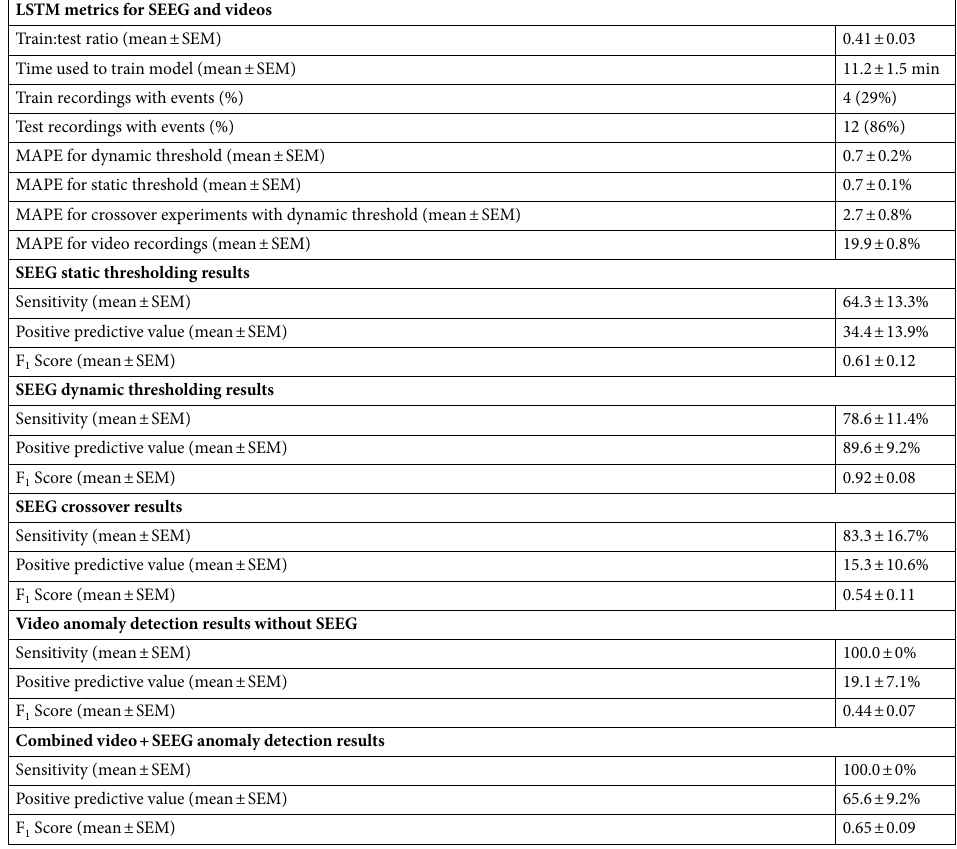
Table 2. Neural network specifications and results. MAPE mean absolute percent error, SEEG stereoelectroencephalography, SEM standard error of the